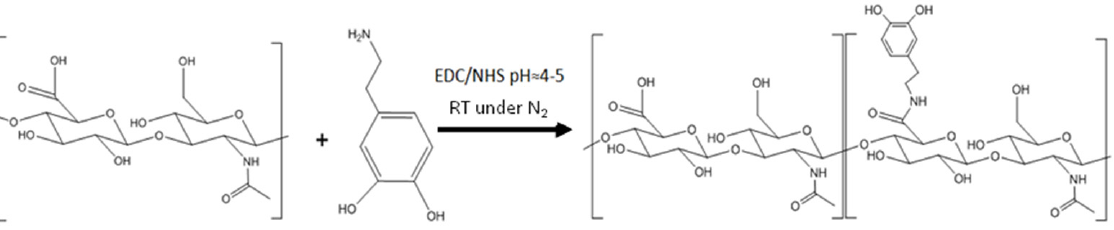
Figure 4. HA-CA synthesis reaction at pH = 4–5 at room temperature and under nitrogen atmos- phere.